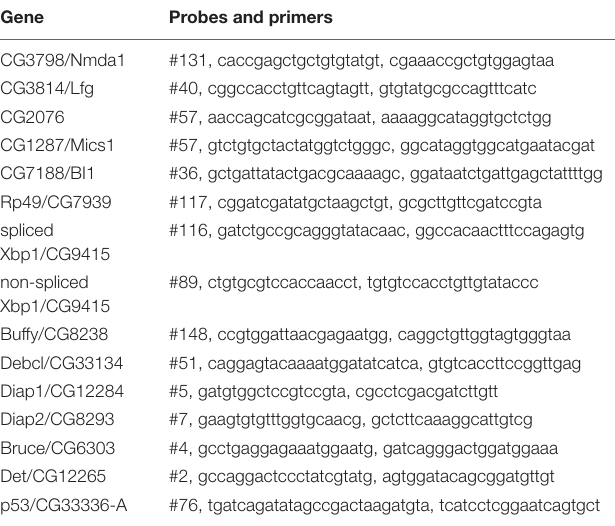
TABLE 2 | List of probes and primers.